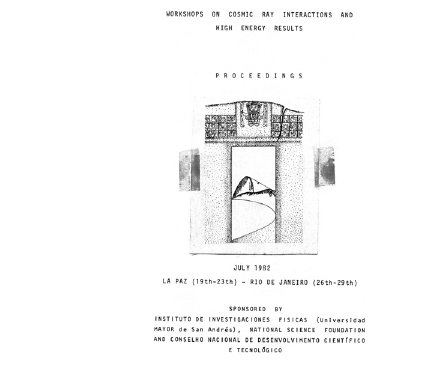
Table 1. Comparison of similar words